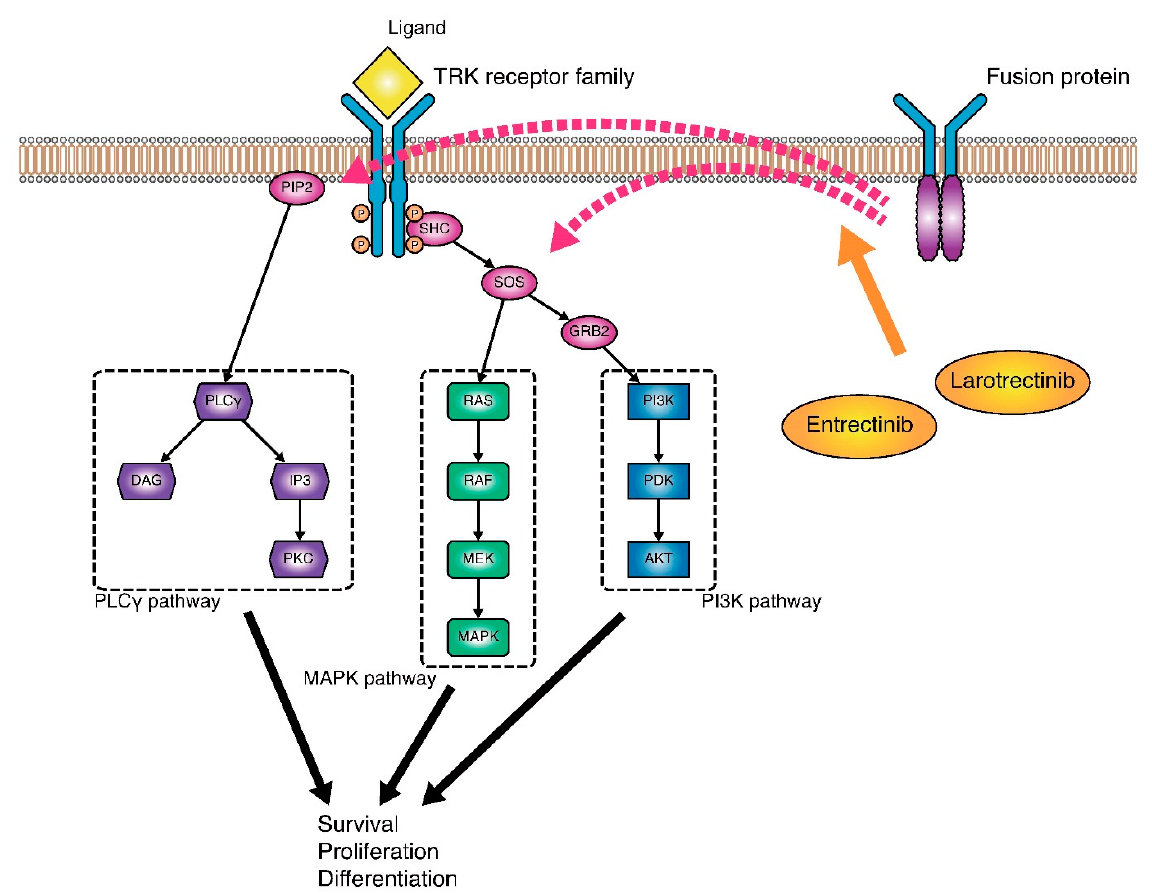
Figure 3. TRK pathway and mechanism of TRK inhibitors. The activation of TRK receptors (TRKA, TRKB, and TRKC) by the binding of the ligand neurotrophin promotes cell survival, proliferation, and differentiation through downstream PLC γ , MAPK, and PI3K pathways. Functional TRK-fusion proteins induce the ligand-independent activation of the tyrosine kinase domain to upregulate downstream cancer-related pathways. TRK inhibitors are tyrosine kinase inhibitors of TRK receptors and inhibit cancer-cell survival and proliferation by suppressing the MAPK pathway.